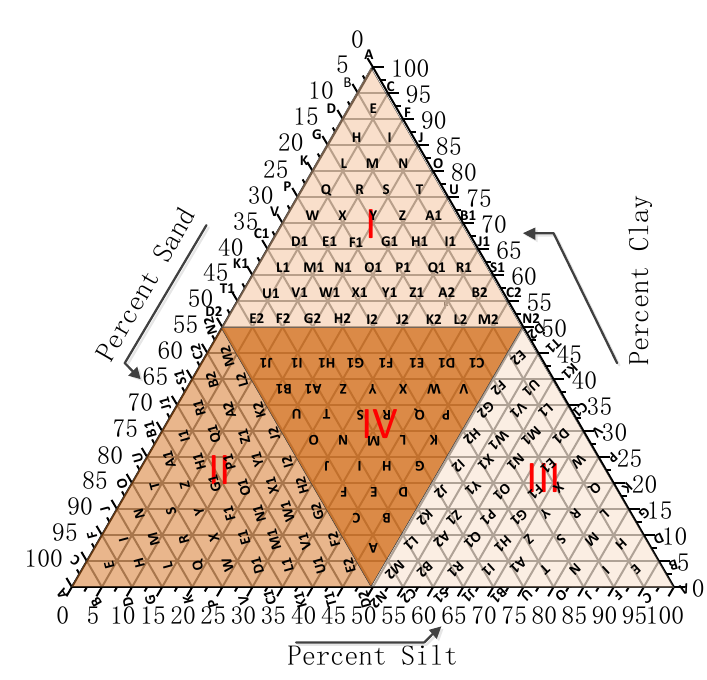
Figure 1. Soil texture grouping diagram according to the gravimetric weights of soil particles.